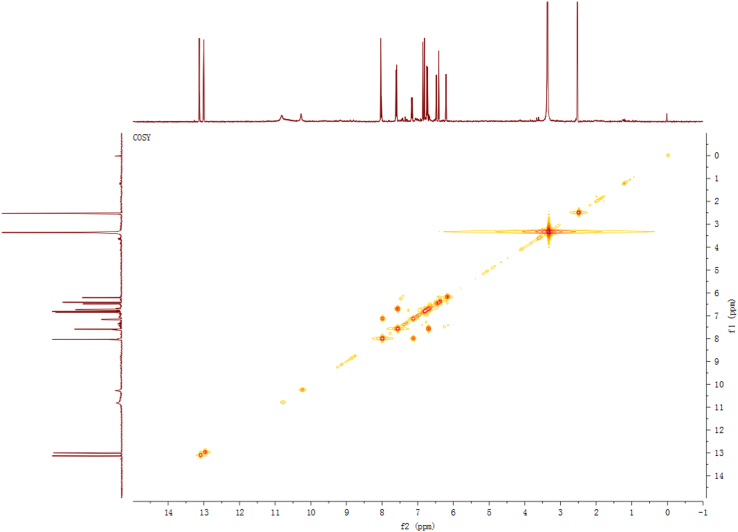
1H–1H COSY spectrum of compound 12.